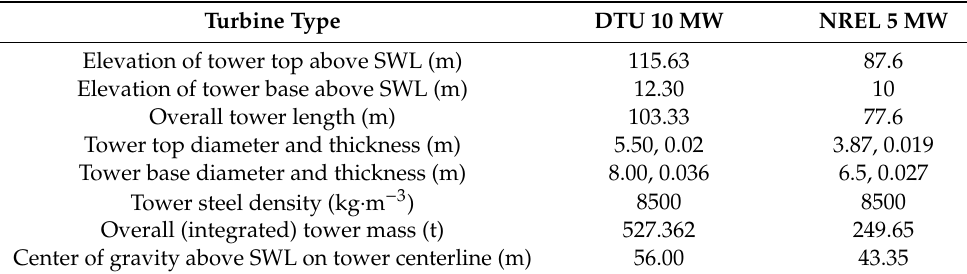
Table 2. Properties of the tower of the floating o ff shore wind turbine (FOWT).